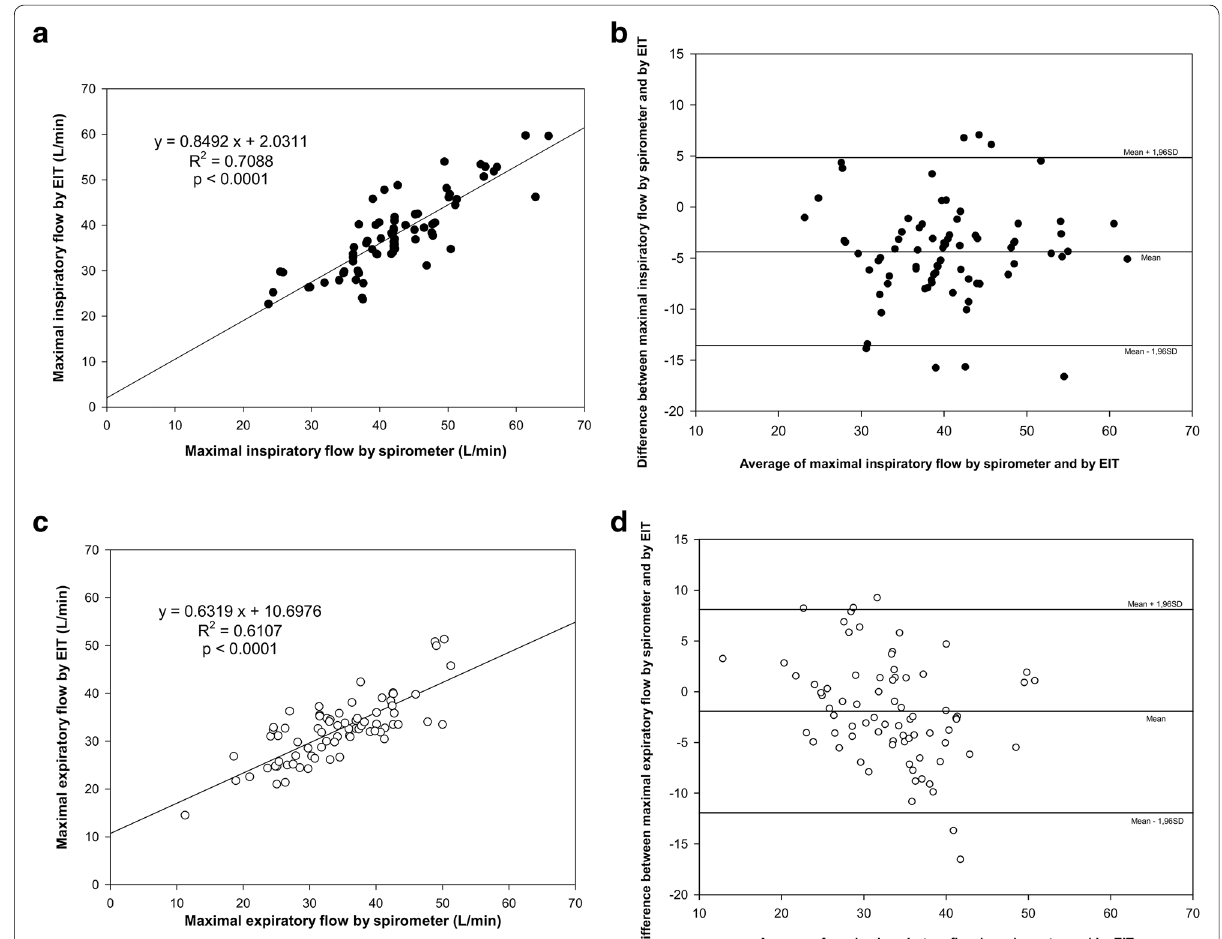
Fig. 2 Correlations and Bland–Altman plots of airflows measured by spirometer and electrical impedance tomography (EIT). Top panels ( a , b ) show data for maximal inspiratory flow (MIF), while bottom panels ( c , d ) for maximal expiratory flow